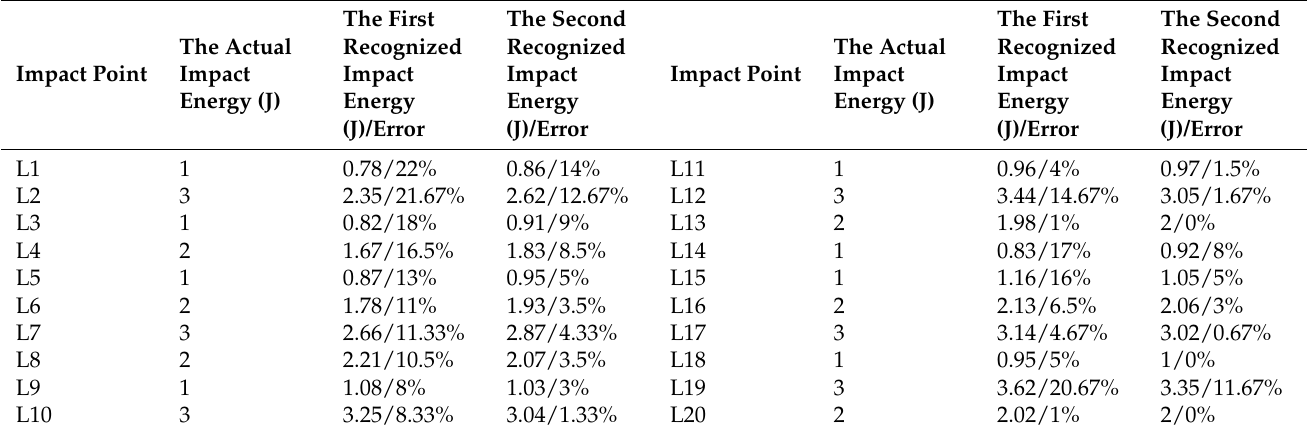
Table 7. Recognition results of the 20 verification